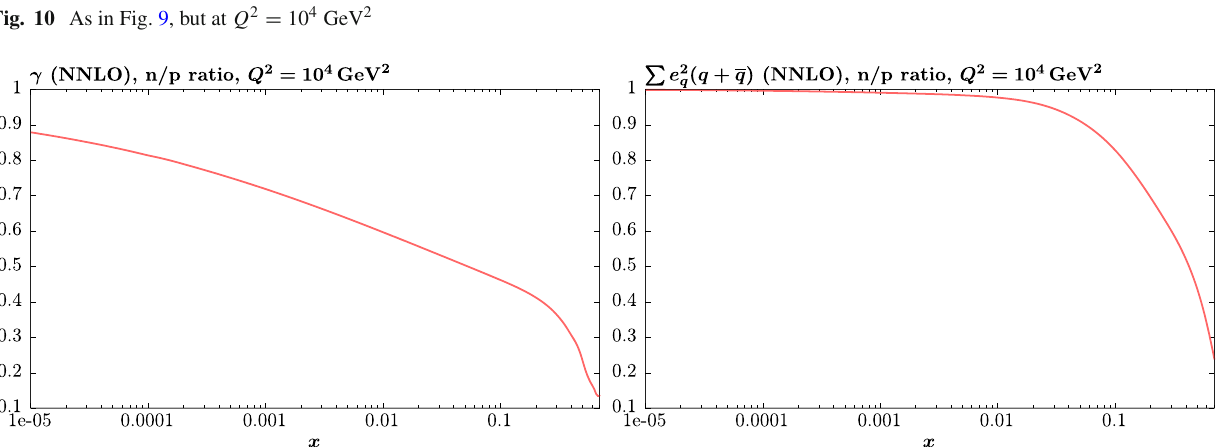
Fig. 11 Ratio of neutron photon (charge-weighted singlet) PDFs to the proton case, at Q 2 = 10 4 GeV 2 , shown in the left (right) plots